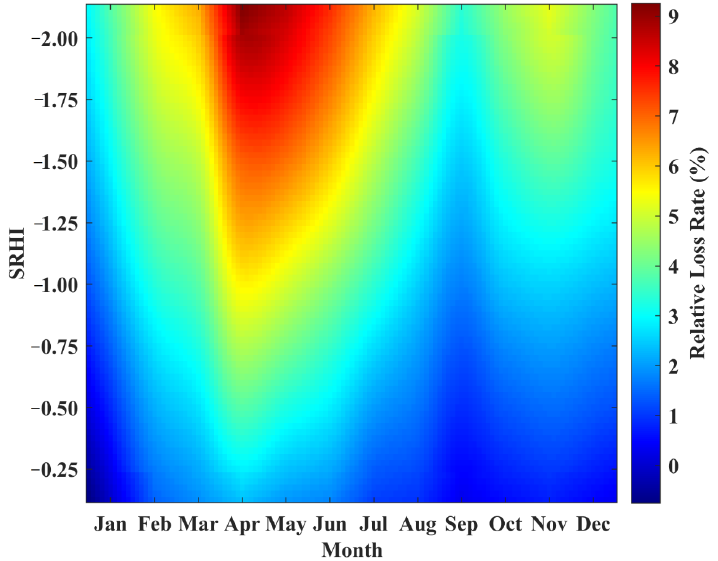
Figure 4. Vulnerability curves of rubber plantations’ GPP to different drought intensities and the month the drought occurs.